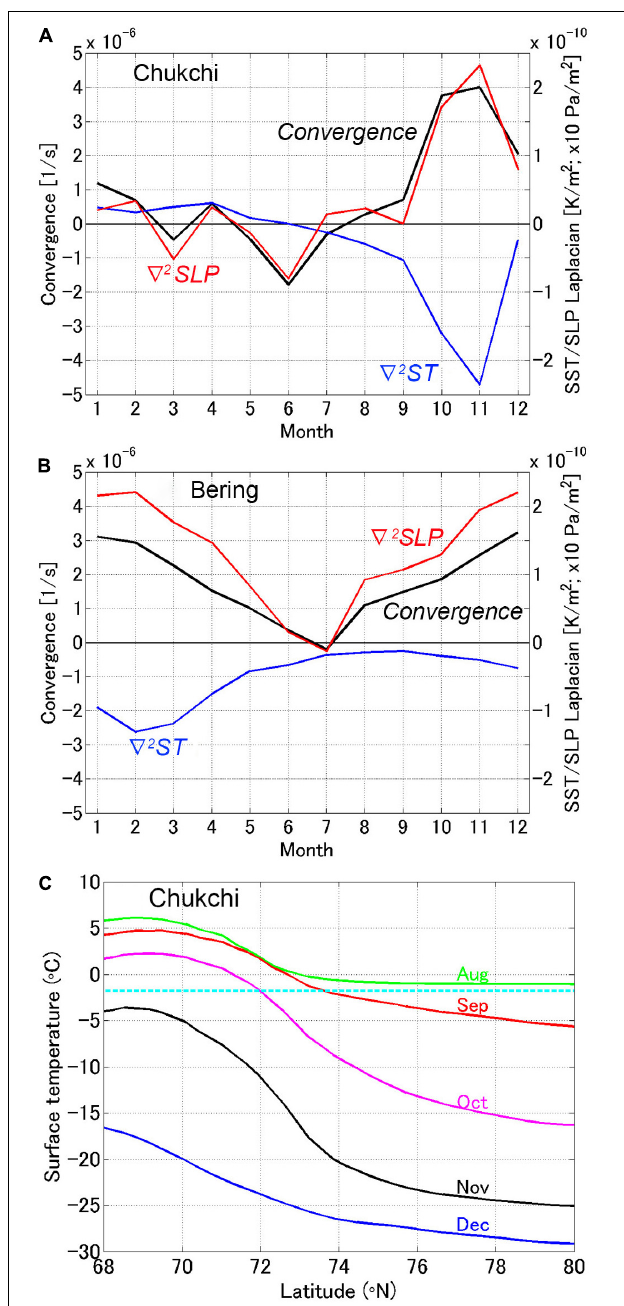
FIGURE 4 | Monthly climatology of 10-m-high wind convergence and the Laplacians of ST and SLP averaged over the black-solid box area in Figure 2 in (A) the Chukchi Sea and (B) the Bering Sea. (C) Monthly climatological data of ST averaged between 167.5 and 174.0 ◦ W in the Chukchi Sea. Cyan dashed line represents a temperature of -1.8 ◦